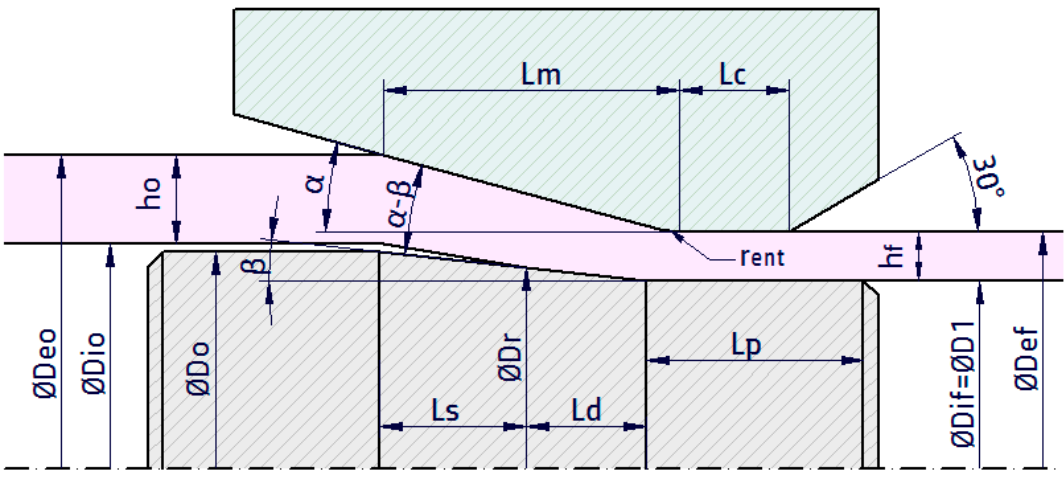
Figure 5. Geometrical parameters implemented in the finite element (FE) model.